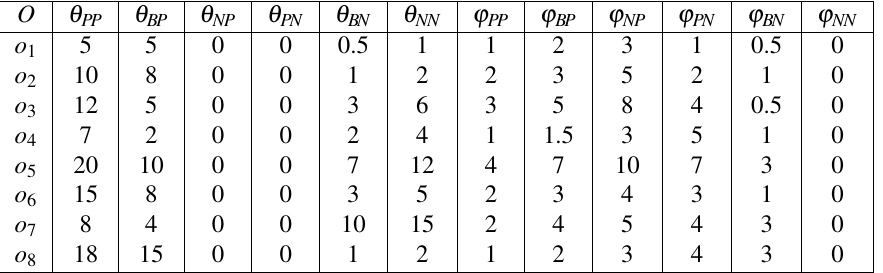
Table 1. Avenues and costs of eight types of oilfield (Unit: mil- lion US $)